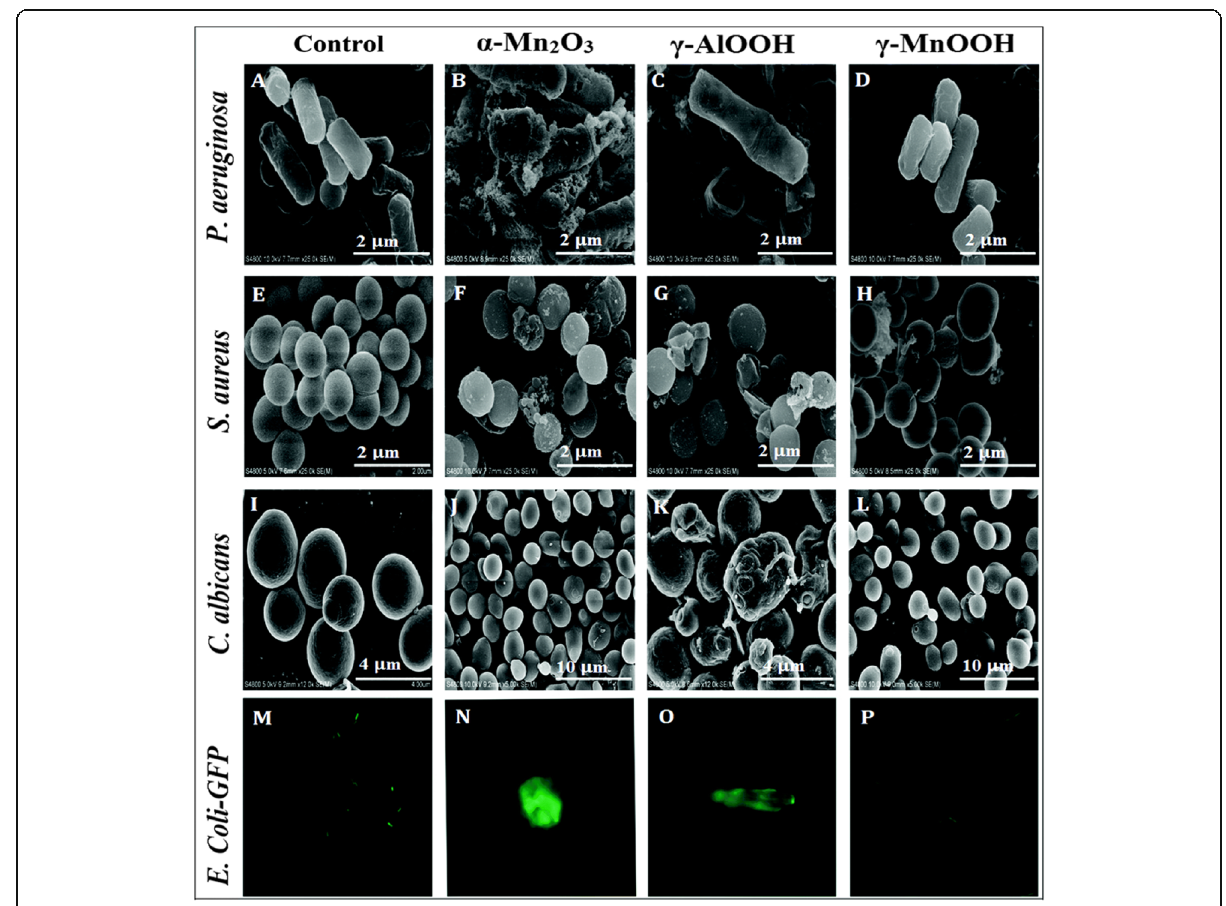
Fig. 7 SEM images of untreated and treated bacterial strains using the prepared NRs; where a − d are for P. aeruginosa , e − h for S. aureus , i − l for C. Albicans , and m − p for E. coli-GFP as a control (untreated) and treated with α -Mn 2 O 3 , γ – AlOOH, and γ – MnOOH NRs, respectively. Reproduced from ref. [9] with permission from The Royal Society of